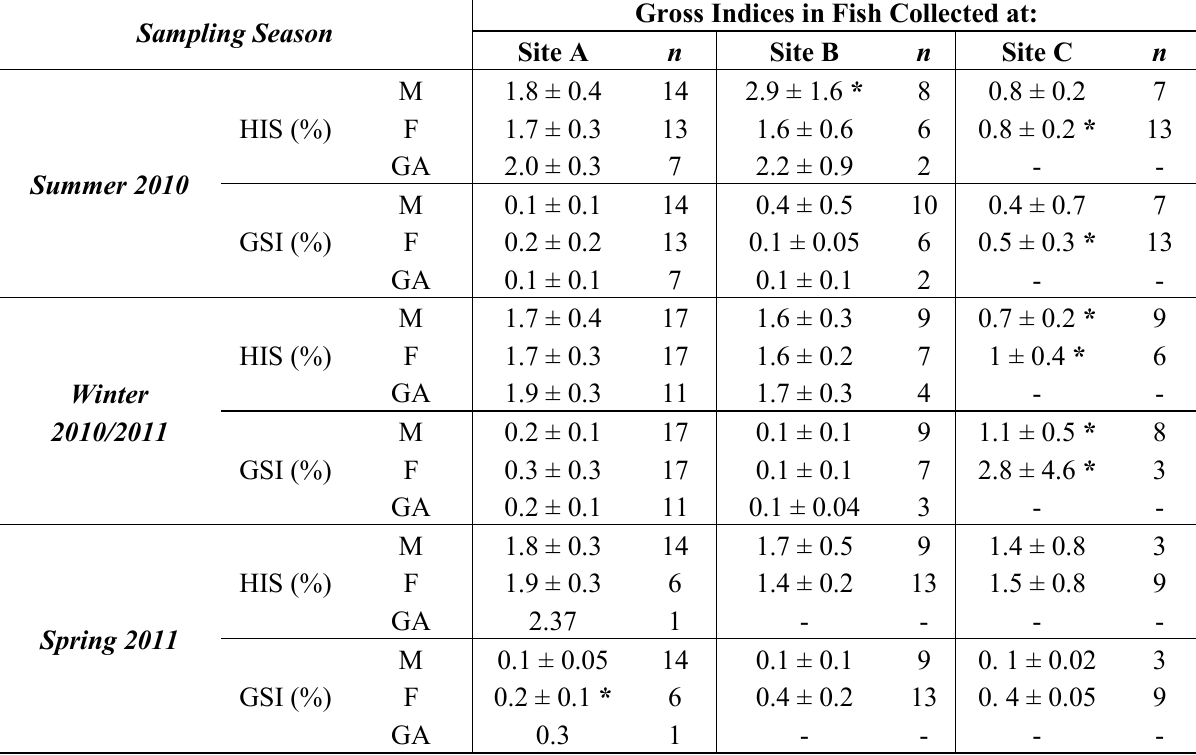
Table 5. Gross indices (HSI and GSI) in thinlip grey mullets collected from the Tiber river sites (A and B) and the LEEA pond (site C), according to the sampling season. Data (mean ± SD) are presented separately for male (M), female (F), and fish with gross gonadal anomalies (GA) detected at gross examination. n = number of fish examined. For each parameter, asterisks ( * ) denote statistically significant differences between the sites, for p <